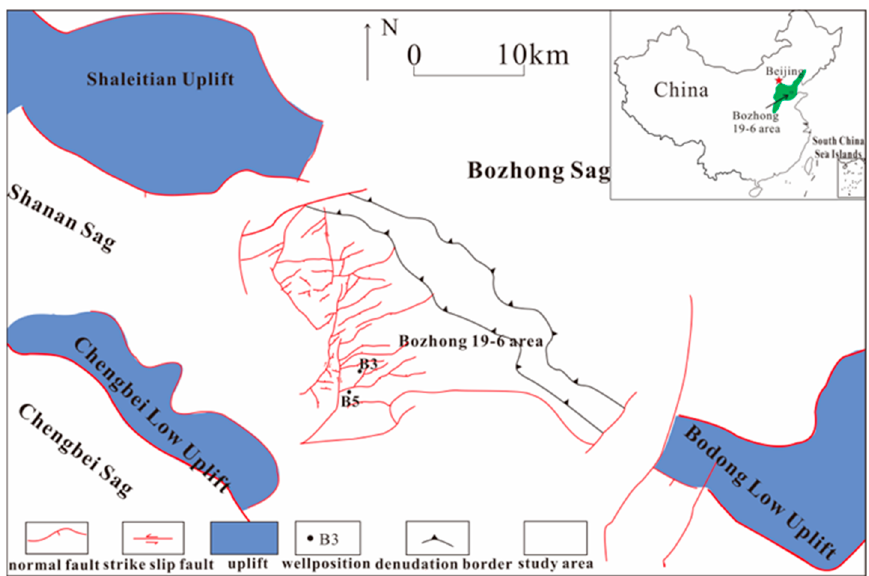
Figure 1. Study area of the Bozhong 19-6 area in the Bozhong Sag.